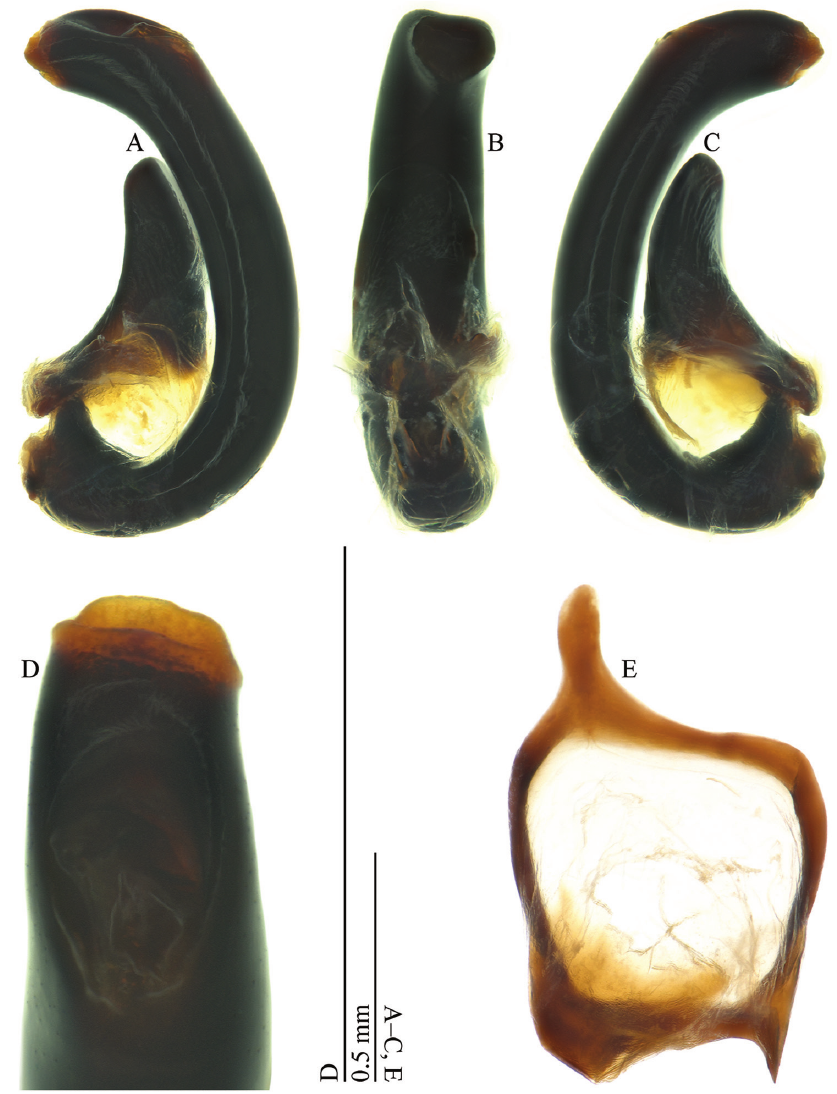
Figure 5. Omoglymmius ( s. str. ) wukong sp. n. (paratype, ♂ ). A–C aedeagus D median lobe E genital ring. ( A right lateral view B, E ventral view C left lateral view D dorsoapical view). num with only a few coarse punctures sparsely located along the midline; more coarse punctures closely arranged almost into a row near lateral margins; remainder of disc smooth; a shallow median pit present posteriorly. Each abdominal sternum with coarse punctures arranged into two or three irregular transverse rows; sternum IV with deep, round lateral pits; sternum V without visible pits; sternum VI with two setae near api- cal